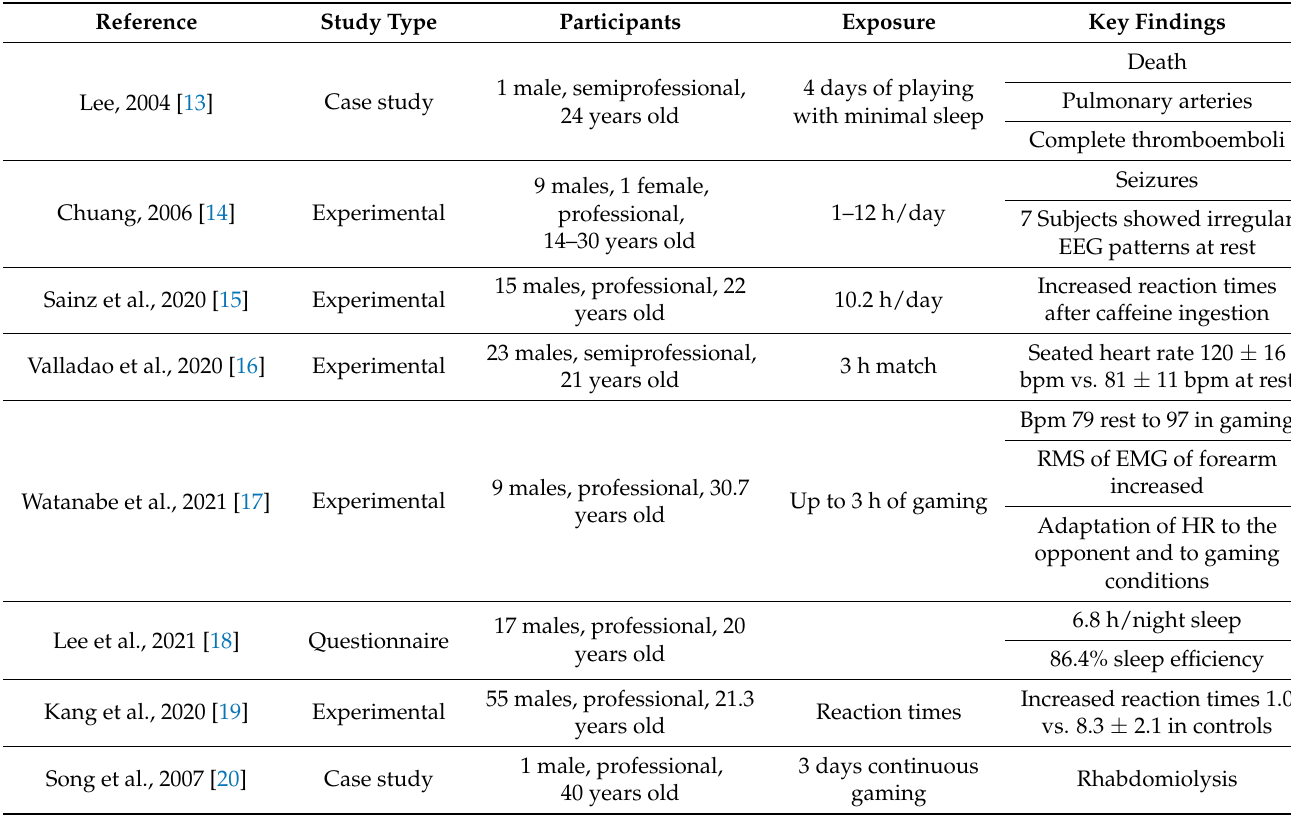
Figure 1. Flow chart of the literature selection. Table 1. Studies on professional and semiprofessional e-gamers.